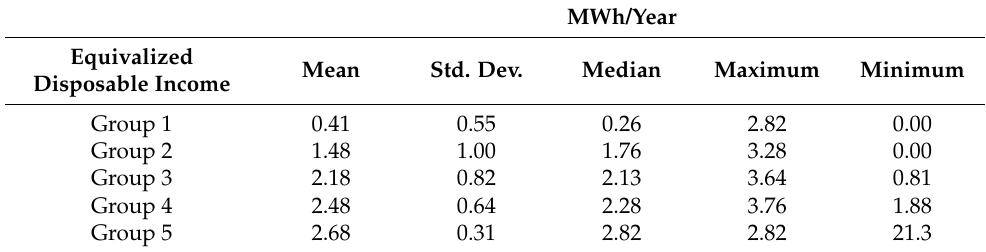
Table 5. Statistical data of inhabitant consumption.